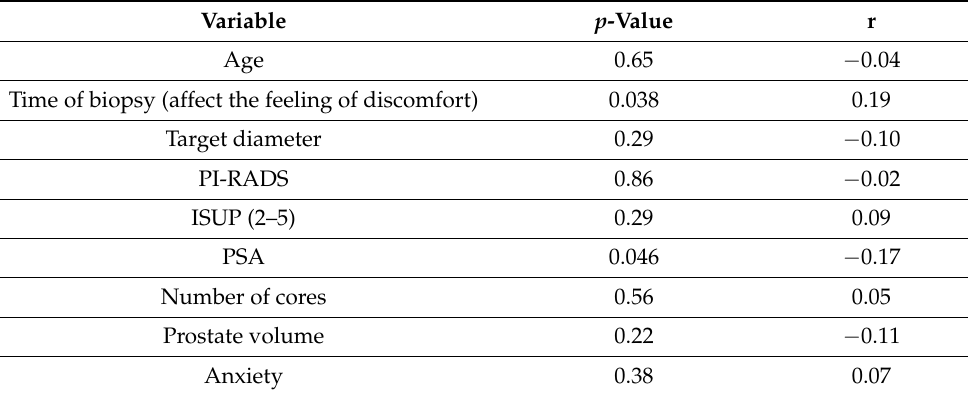
Table 3. The results of the analysis of correlation of particular variables on the level of pain experi- enced during the